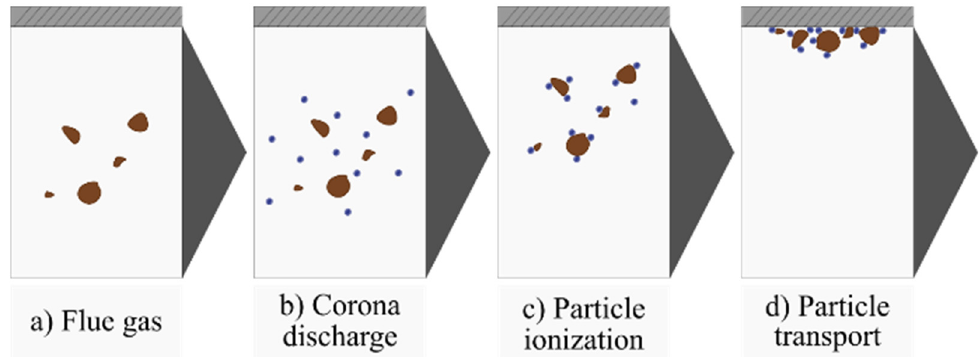
Figure 4. The main stages of particle collection of an ESP, starting with the corona discharge and gas ionization, to particle transport.